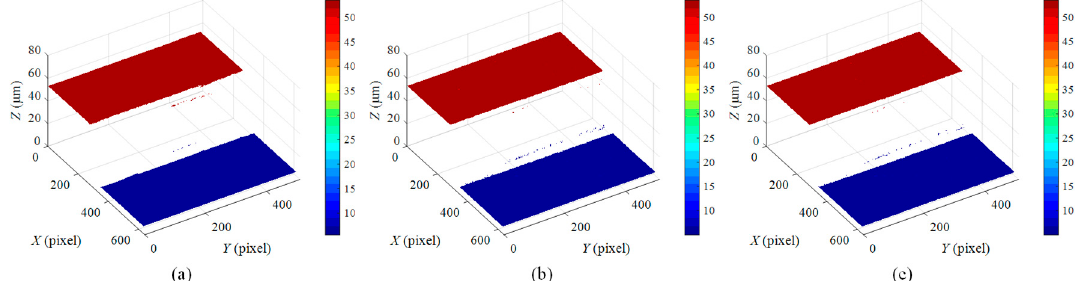
Figure 11. Surface profile of 47.022 μ m step height reconstructed by using: ( a ) centroid method, ( b ) FFT method, ( c ) HT method.